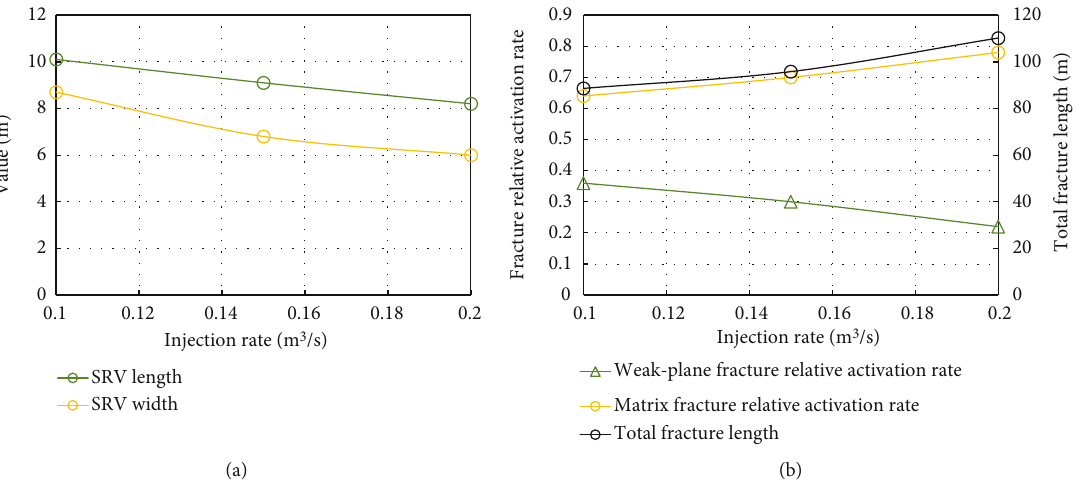
Figure 10: In fl uence of fracturing fl uid injection rate on SRV (a) and relative fracture activation